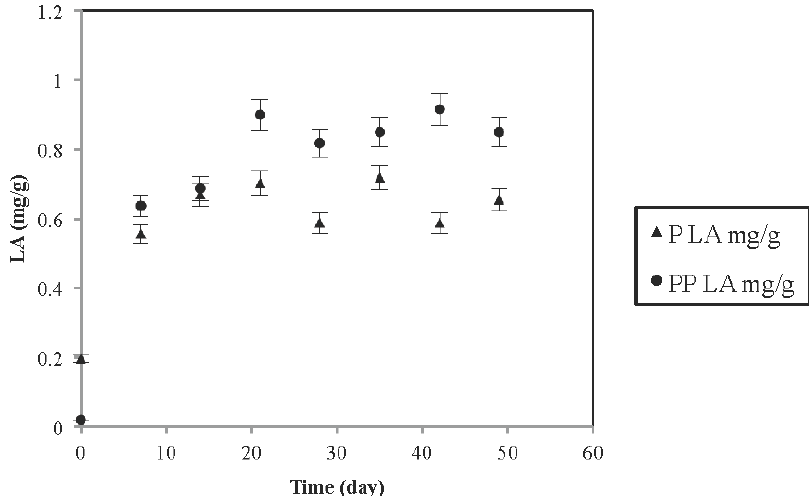
Figure 1. The changes of acidity for fermentation with the effect of